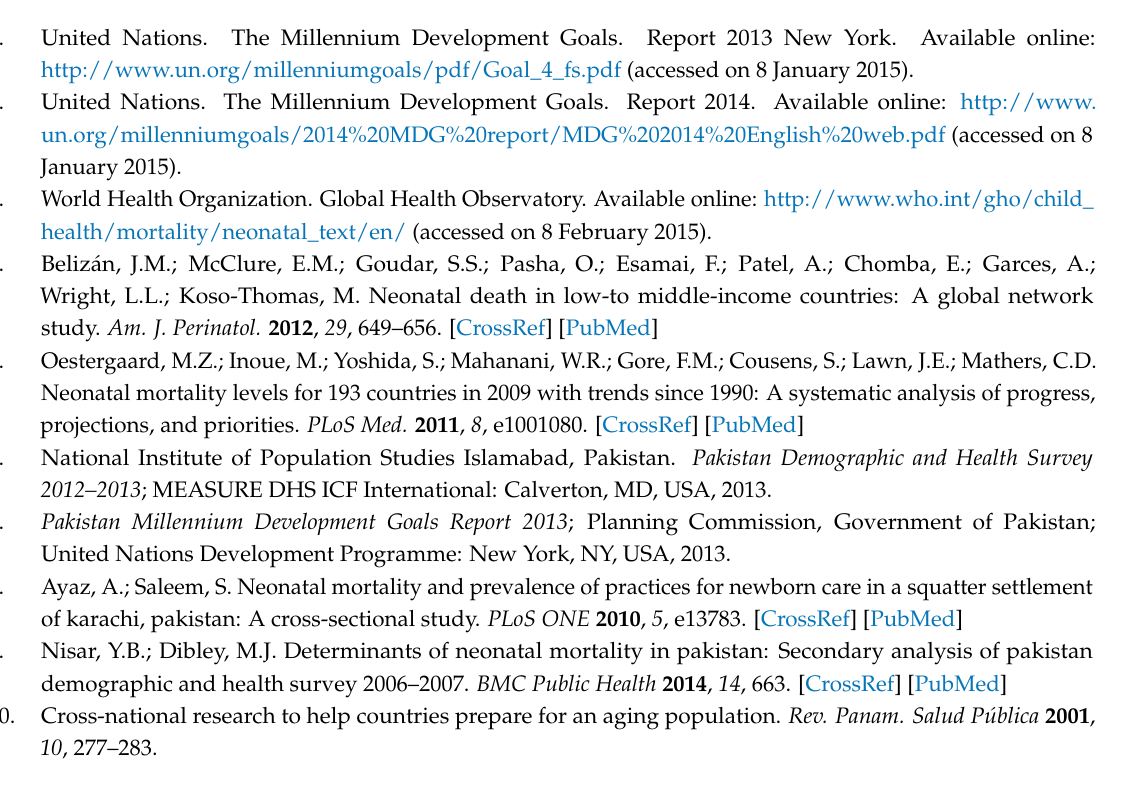
Table S1: Search